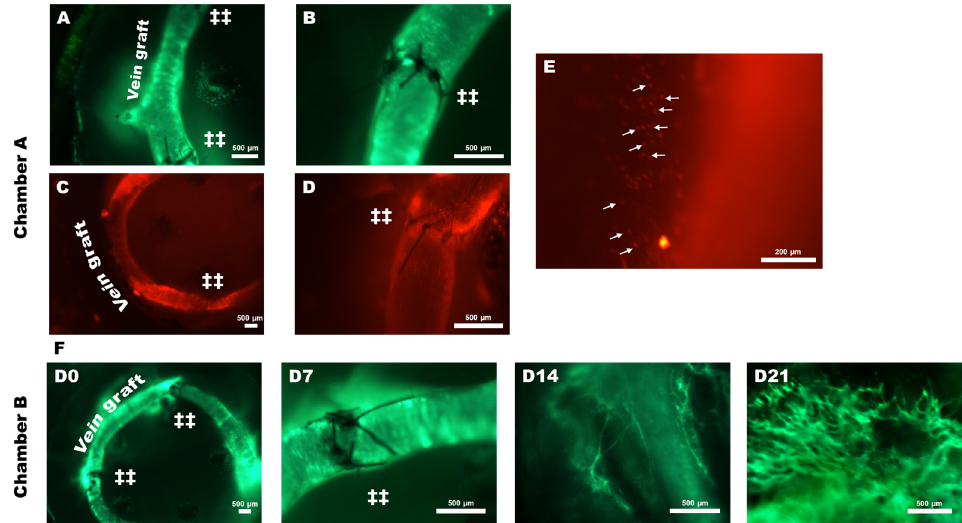
Figure 4. Chamber A IVM. AV loop vessels were visualized by injecting FITC-Dextran dye, which stains the blood plasma ( A , B ); scale bar: 500 μ m. Leukocyte–endothelial cell interactions can be examined using rhodamine 6G (a pan-leukocyte marker) dye ( C , D ); scale bar: 500 μ m. ( E ) A representative image showing firmly attached leukocytes to the vessel wall. Scale bar: 200 μ m. ( firmly adherent leukocytes). ( F ) Chamber B IVM was performed on days 0, 7,14, and 21. No microvessels were observed on day 7. On day 14, vascular sprouts were first observed. Microvessels were also observed on day 21. Scale bar 500 μ m. (‡‡: microsurgical anastomosis).